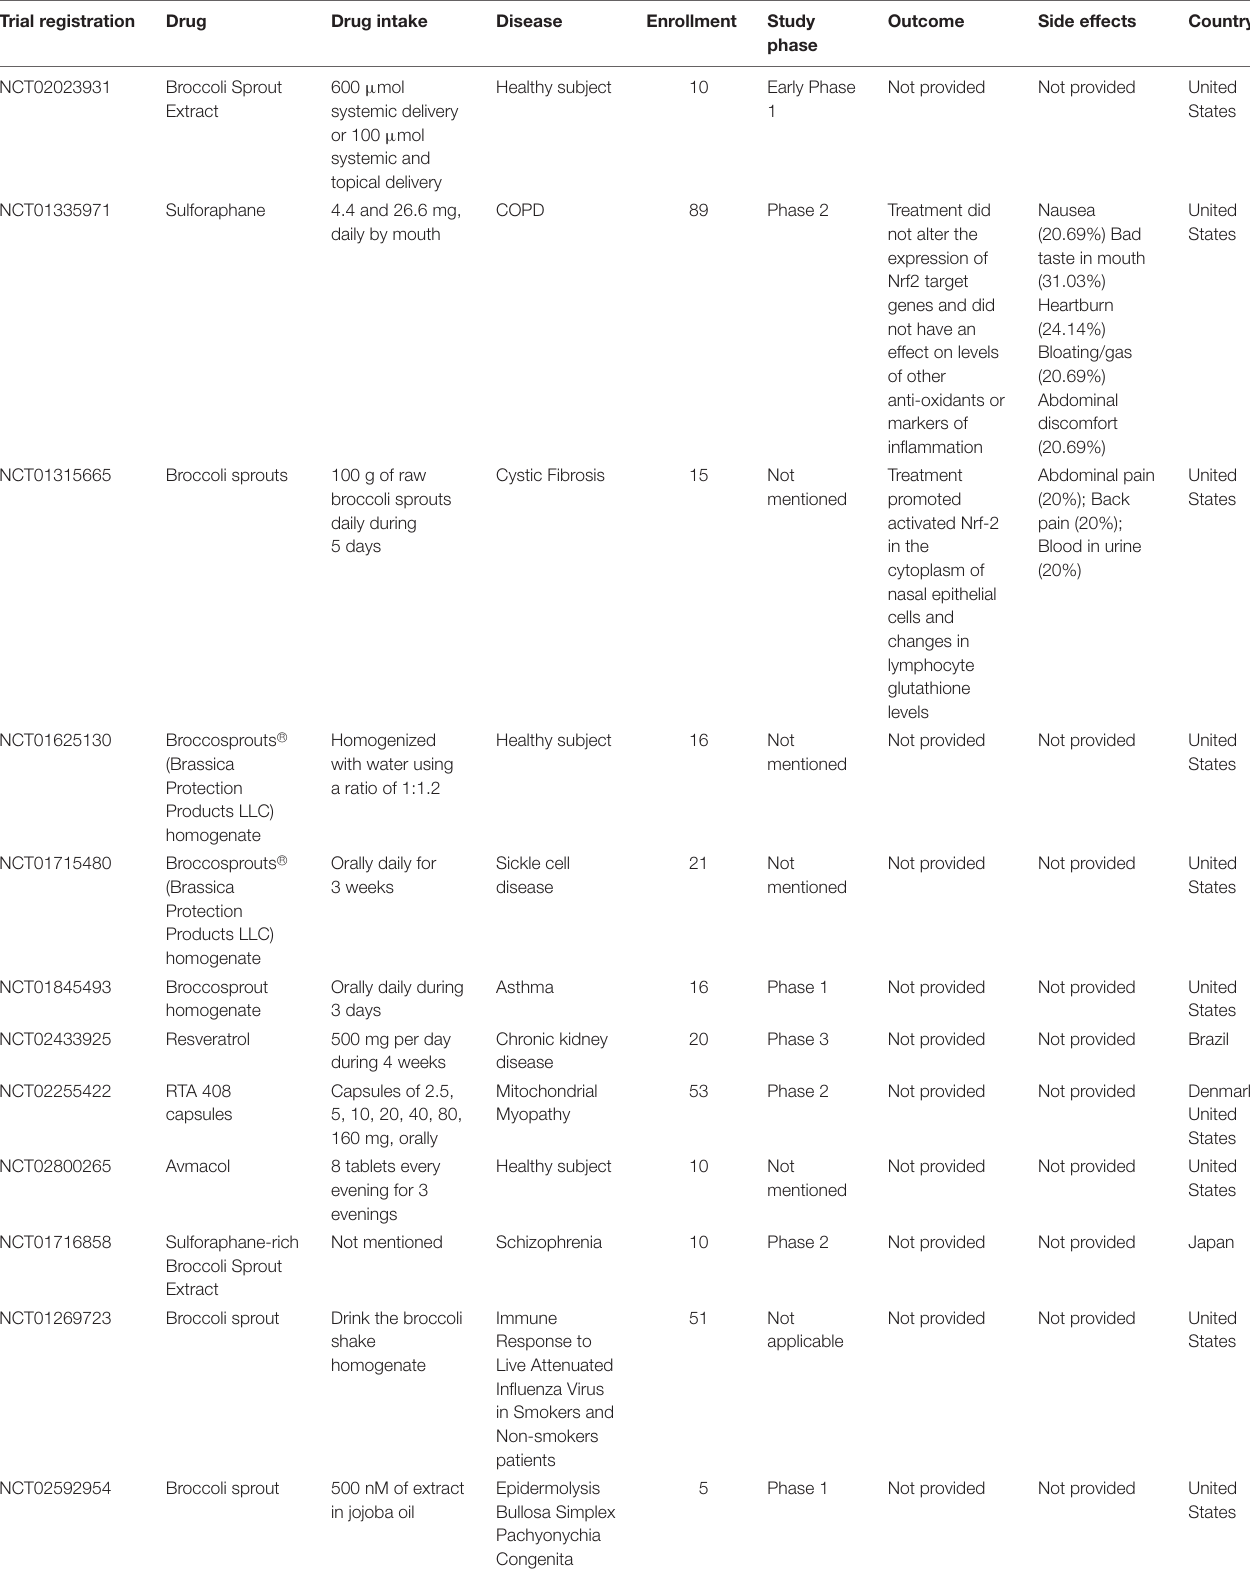
TABLE 2 | Complete clinical trials related to